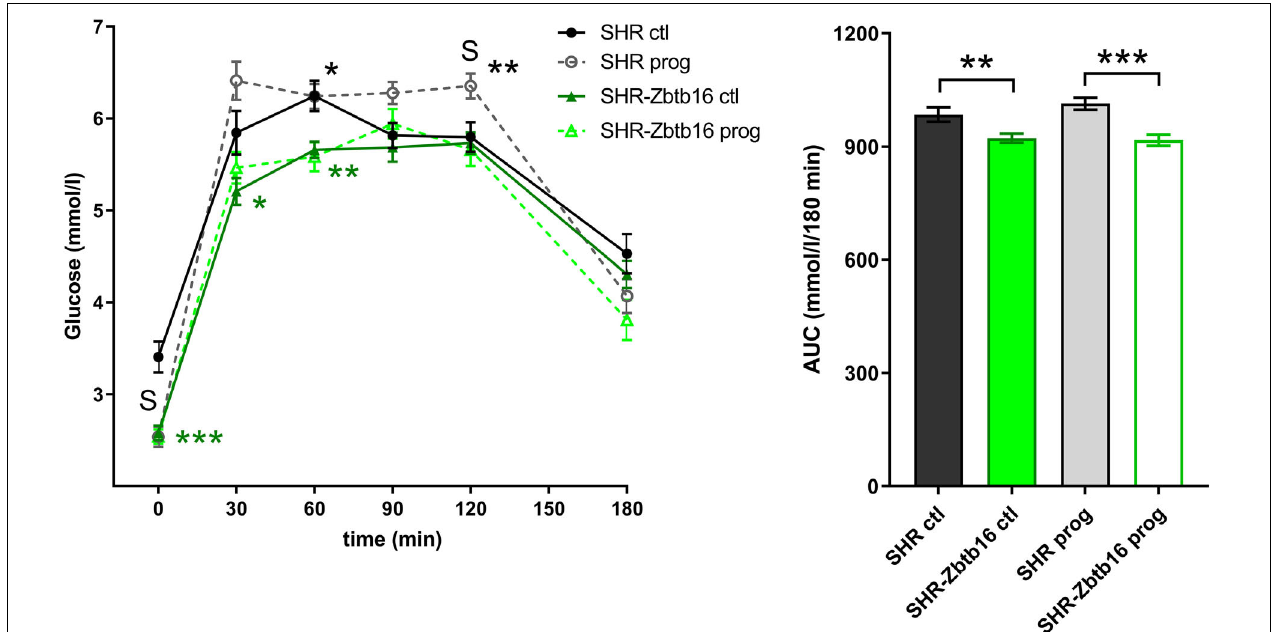
FIGURE 9 | The oral glucose tolerance test (OGTT). The course of glycemic curves in adult SHR control males (SHR ctl, black circles), SHR males programmed with maternal HSD (SHR prog, empty gray circles), SHR- Zbtb16 control males (SHR- Zbtb16 ctl, dark green triangles), SHR- Zbtb16 males programmed with maternal HSD (SHR- Zbtb16 prog, light-green empty triangles) during the oral glucose tolerance test with corresponding areas under the curves (AUC). Data are expressed as mean ± SEM. Within the graph, the significance levels of pair-wise comparisons by repeated-measures two-way ANOVA (OGTT) and post-hoc Fisher’s test of the two-way ANOVA (AUC) ANOVA with STRAIN and MATERNAL DIET as major factors are indicated as follows: * p < 0.05, ** p < 0.01, *** p < 0.001. Green asterisks (*) show strain differences between SHR ctl and SHR- Zbtb16 ctl, black asterisks (*) show strain differences between SHR prog and SHR- Zbtb16 prog rats. S represents differences between SHR ctl and SHR prog rats: t = 0 min ∗∗∗ , t = 120 min ∗